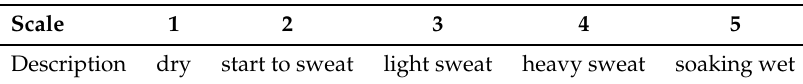
Table 2. Perceived Perspiration Level [15].